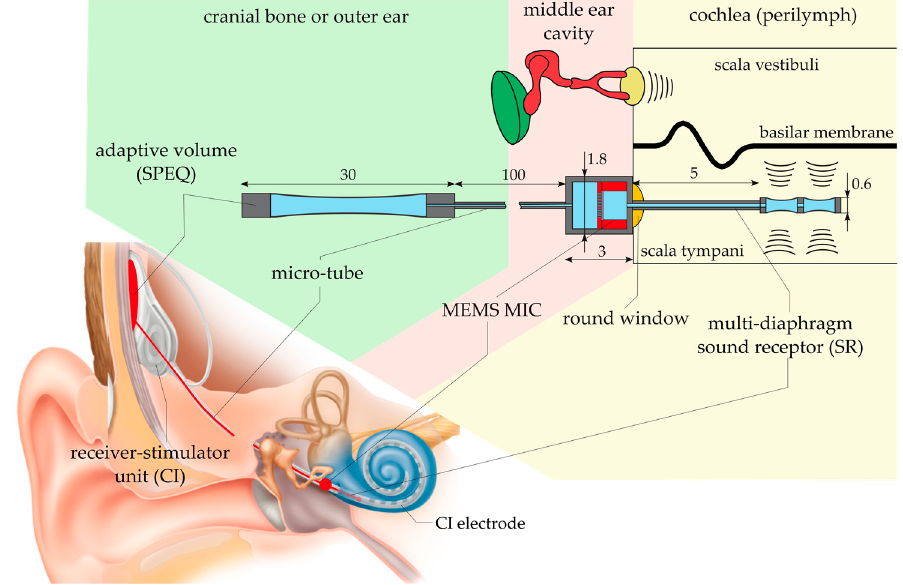
Figure 3. Schematic illustration of the implantable packaging structure protecting an off-the-shelf MEMS microphone (MEMS MIC) against body liquid and vice versa. The location of the individual components of the structure in the human body is indicated schematically and in an anatomical illustration of the human ear. In the latter representation, the intracochlear acoustic receiver (ICAR) is shown as an integral part of a cochlea implant system.